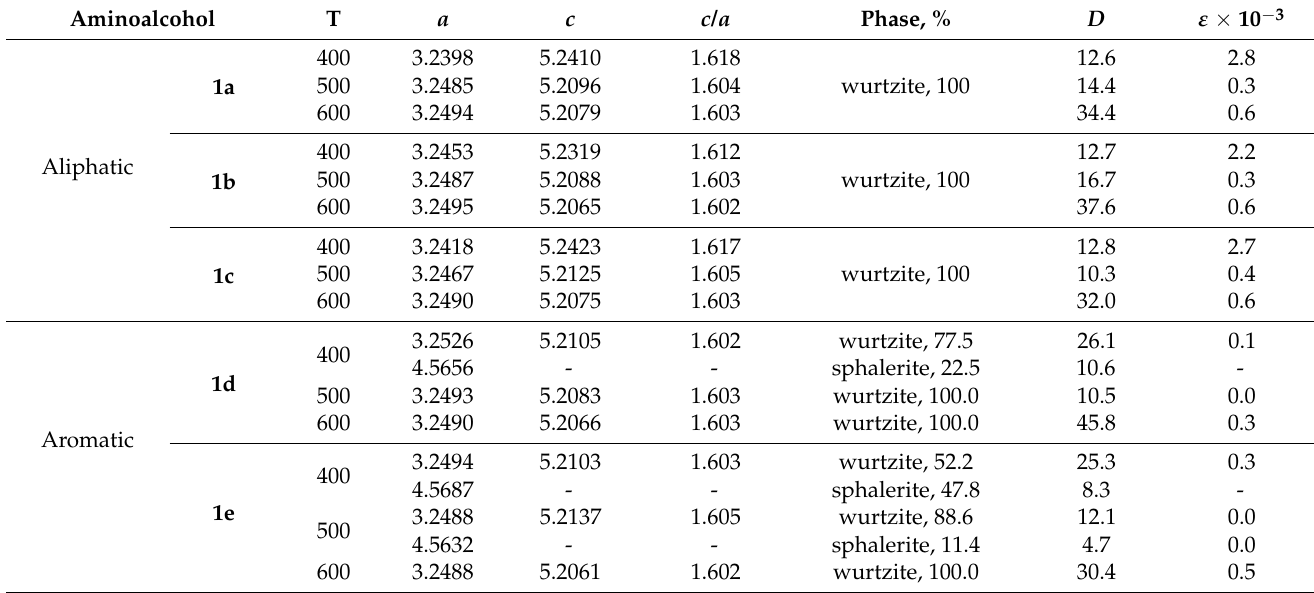
Table 2. Summary of the results obtained from Rietveld XRD studies of films 1a – 1e after annealing at 400, 500, and 600 ◦ C: lattice parameters ( a and c (in Å)) and c/a ratio, ZnO phase present (% in weight), average crystal size ( D in nm), and lattice strain ( ε × 10 –3